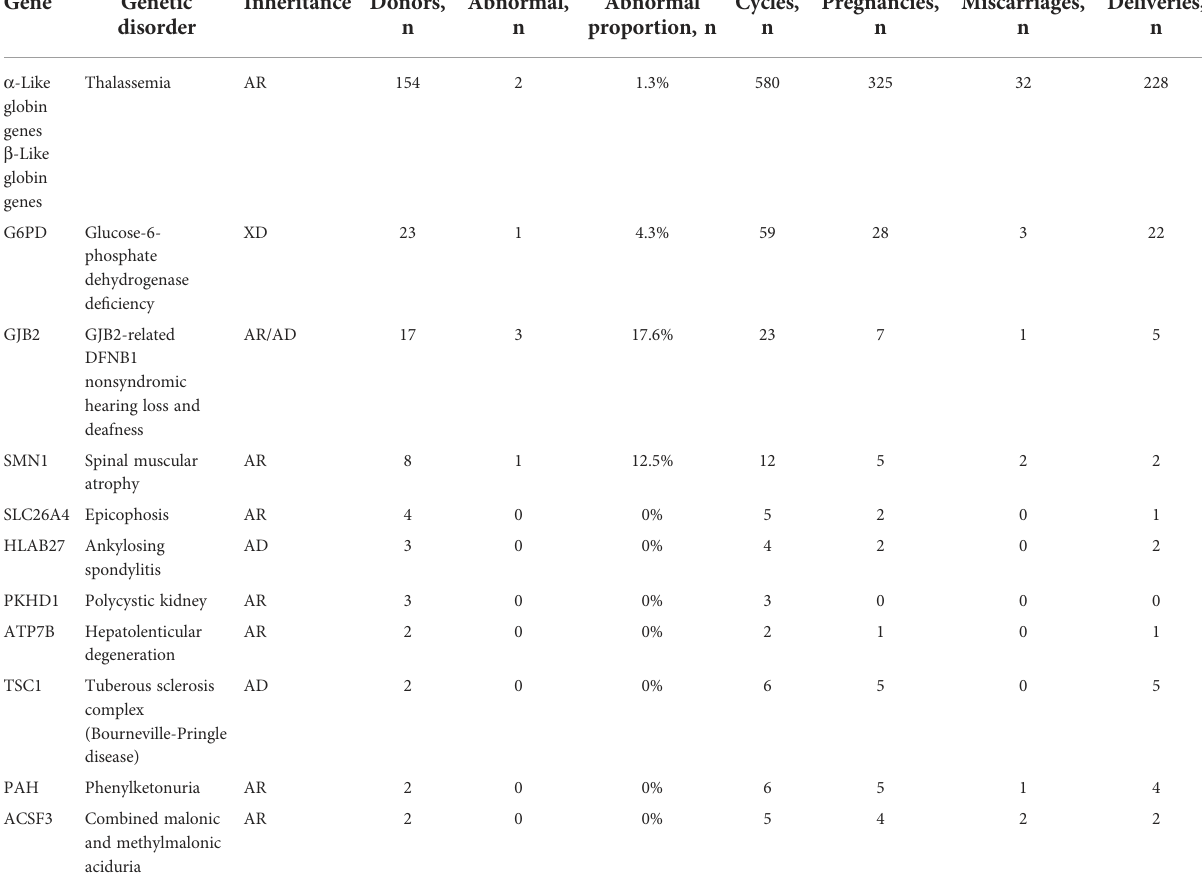
TABLE 2 Genetic testing for speci fi c disorder-related genes for 278 sperm donors in sperm donor applicants.